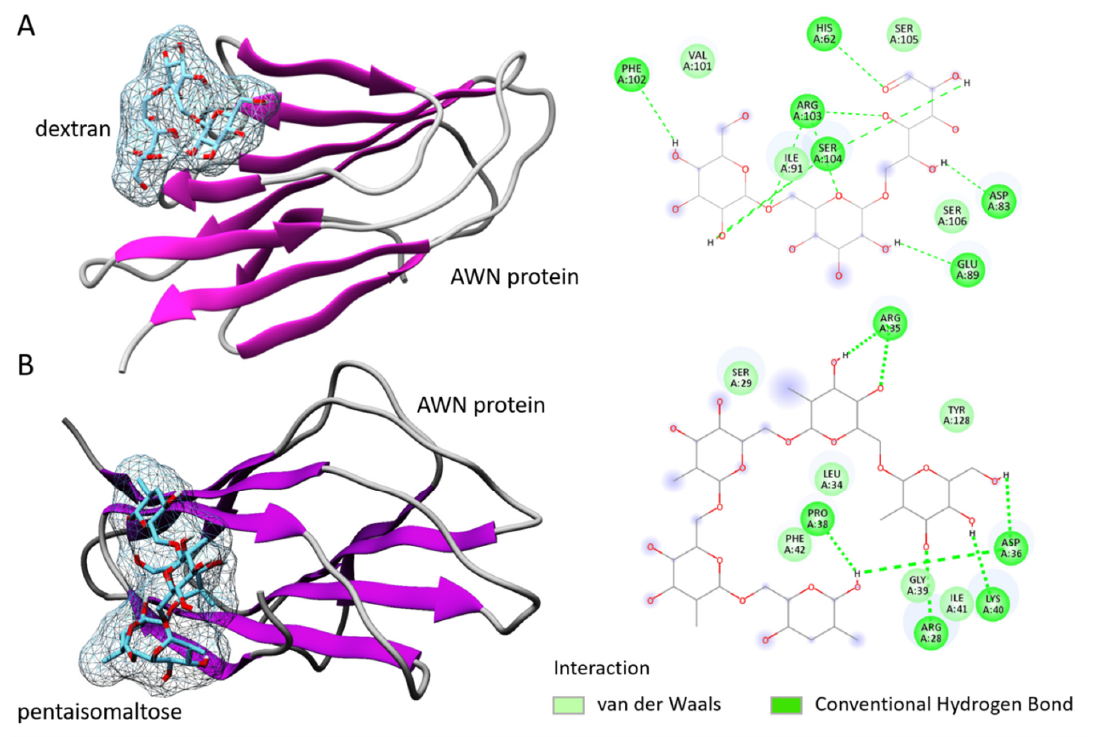
Figure 1. Protein–ligand interaction study. ( A ) Dextran in interacting mode with AWN spermadhesin with specified and interacting amino acids. ( B ) Pentaisomaltose in interacting mode with AWN spermadhesin with specified and interacting amino acids.